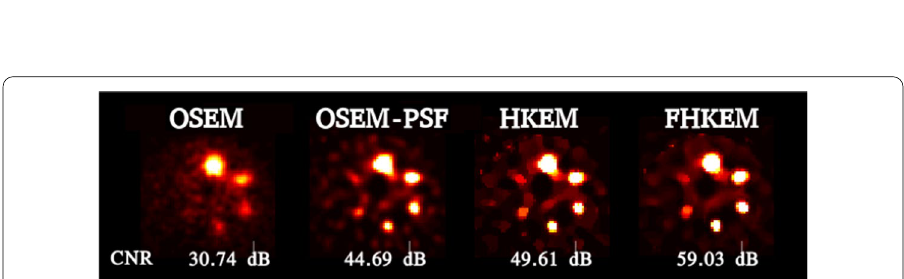
Fig. 4 Comparison between reconstructed images of the NEMA phantom using OSEM, OSEM‑noPSF, HKEM, and FHKEM with functional kernel frozen at the 72nd sub‑iteration. The images correspond to the 50th